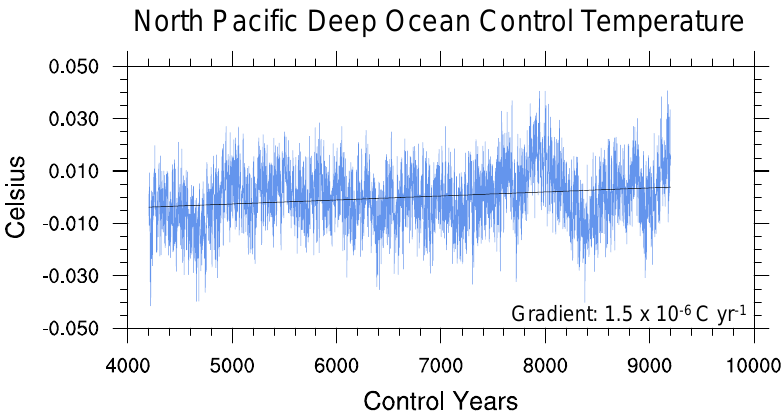
Figure 1. Ocean temperature at 57° N, 180° W, 2000 m depth in the Community Earth System Model (CESM) pre-industrial control simulation, from model year 4000 to 9200, the time period over which transient historical and representative concentration pathway (RCP) simulations are initialized. The timeseries is offset by the average over the control period. The black line shows the linear trend over the 5200 years, and its gradient is inset in the bottom right corner.